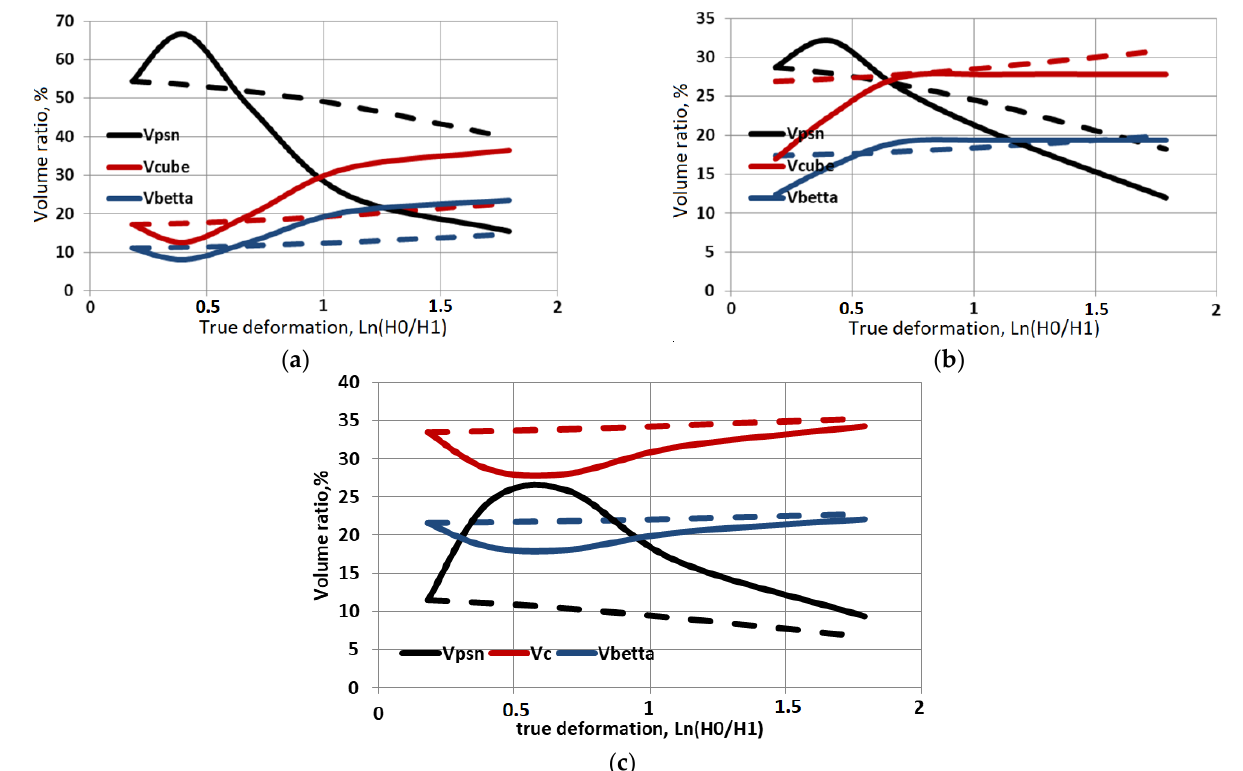
Figure 16. Calculated dependence of the recrystallized material textures on deformation values: taking fragmentation of intermetallic compounds into account = solid curves; disregarding fragmentation = dashed curves; ( a ) 1565 alloy, ( b ) 5182 alloy, ( c ) 8011 alloy.